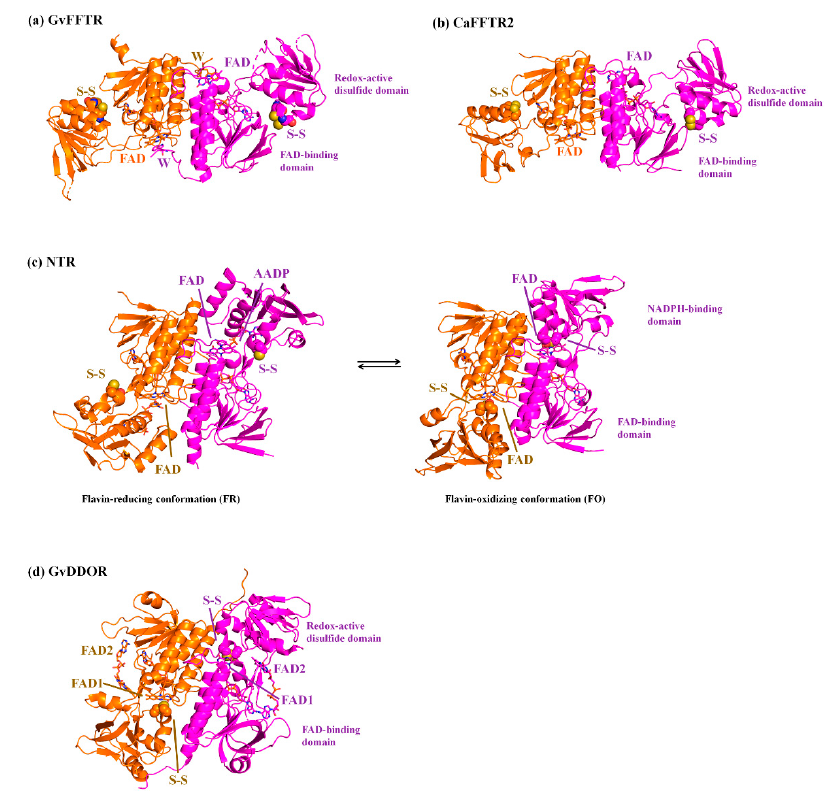
Figure 1. Ribbon representation of the homodimeric protein structures solved by X-ray crystallog- raphy of ( a ) GvFFTR; ( b ) CaFFTR2; ( c ) FR and FO conformations of representative bacterial NTRs (PDB codes 1F6M and 1TRB, respectively); and ( d ) GvDDOR. Each protomer in the homodimer is colored in magenta and orange, respectively, and the two domains for a monomer are labeled. FAD cofactors and tryptophan (W) at the C-tail are depicted in stick representation, whereas the Cys amino acids forming part of the redox-active CxxC motif are represented in spheres. Note that for bacterial FR and FO NTR conformations, the CxxC motif has been mutated to SxxC and CxxS, re- spectively [10,11]. The FR conformation in (– c ) has been solved in the presence of 3-acetylpyridine adenine dinucleotide phosphate (AADP), an NADPH analog [10].